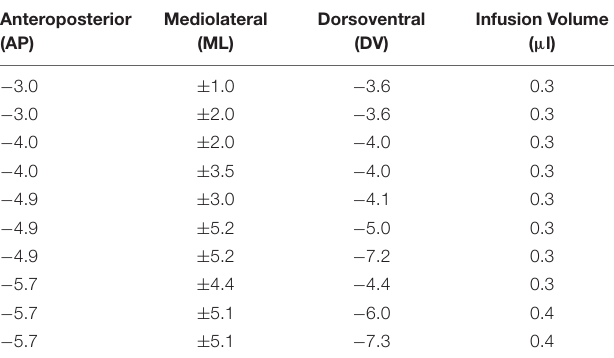
TABLE 1 | Injection coordinates relative to bregma as well as volume of NMDA injected for complete NMDA lesions of the Hippocampus. Anteroposterior